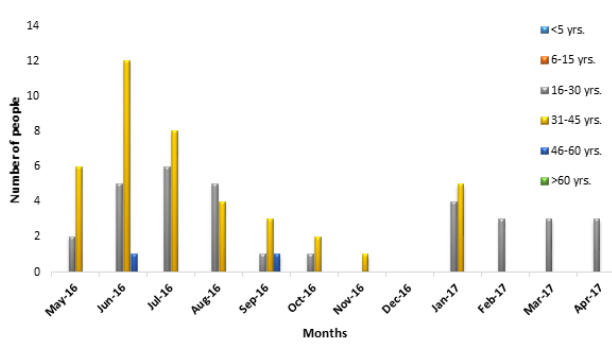
Figure 4 . Number of People Visiting Malarious Areas (OS-N) Categorized Into Different Age